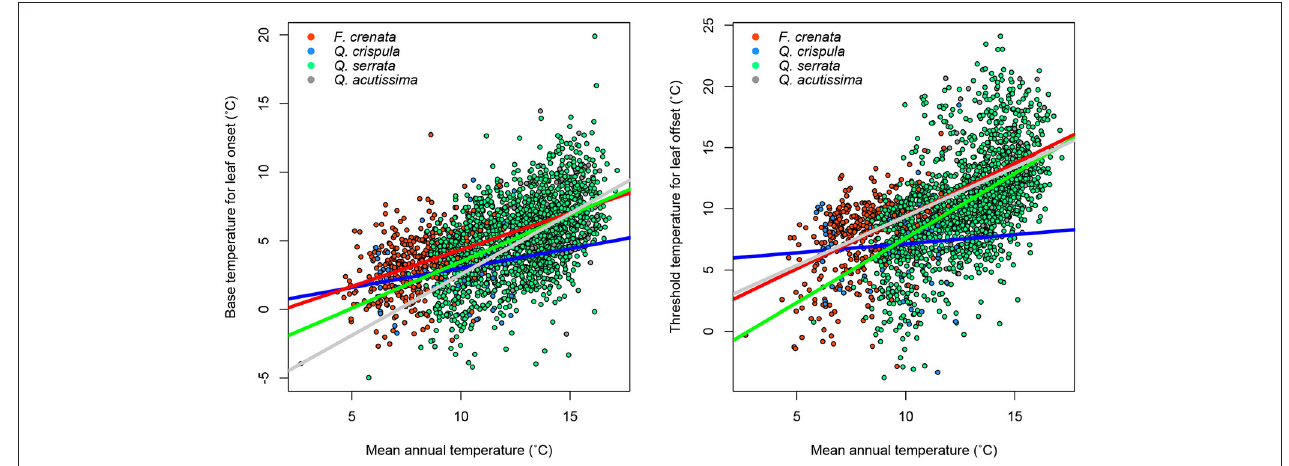
FIGURE 5 | Relationship between mean annual temperature and phenology parameters. The color of dots and lines corresponds to each species. Regression statistics are shown in Supplementary Table 1